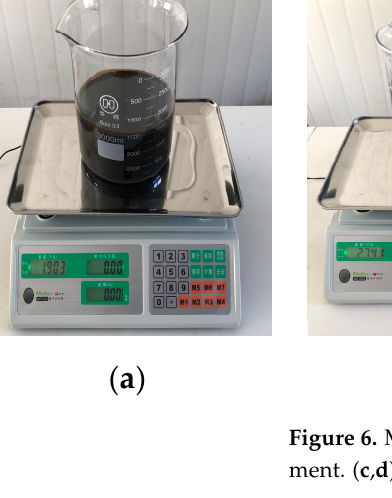
Table 2. Data of the heavy-oil film experiment groups .